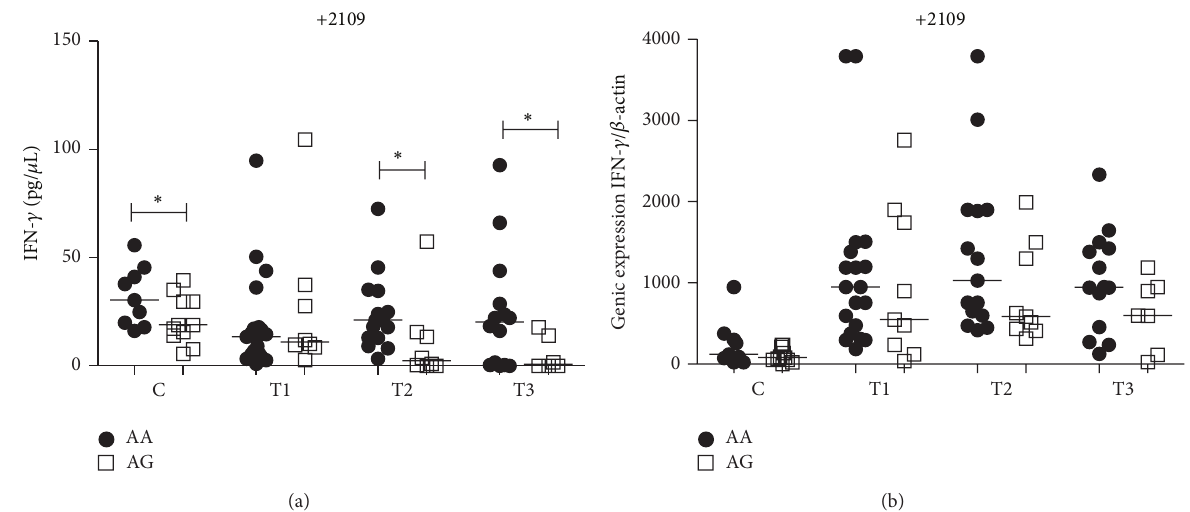
Figure 2: Influence of IFNG +2109A/G gene SNP on IFN- 𝛾 plasma levels (a) and mRNA expression (b) in the control group (C) and PTB patients group at three time points of the treatment: T1 (after diagnosis and first month), T2 (three months), and T3 (six months). Data are shown as median levels. ∗ 𝑃 < 0.05 .